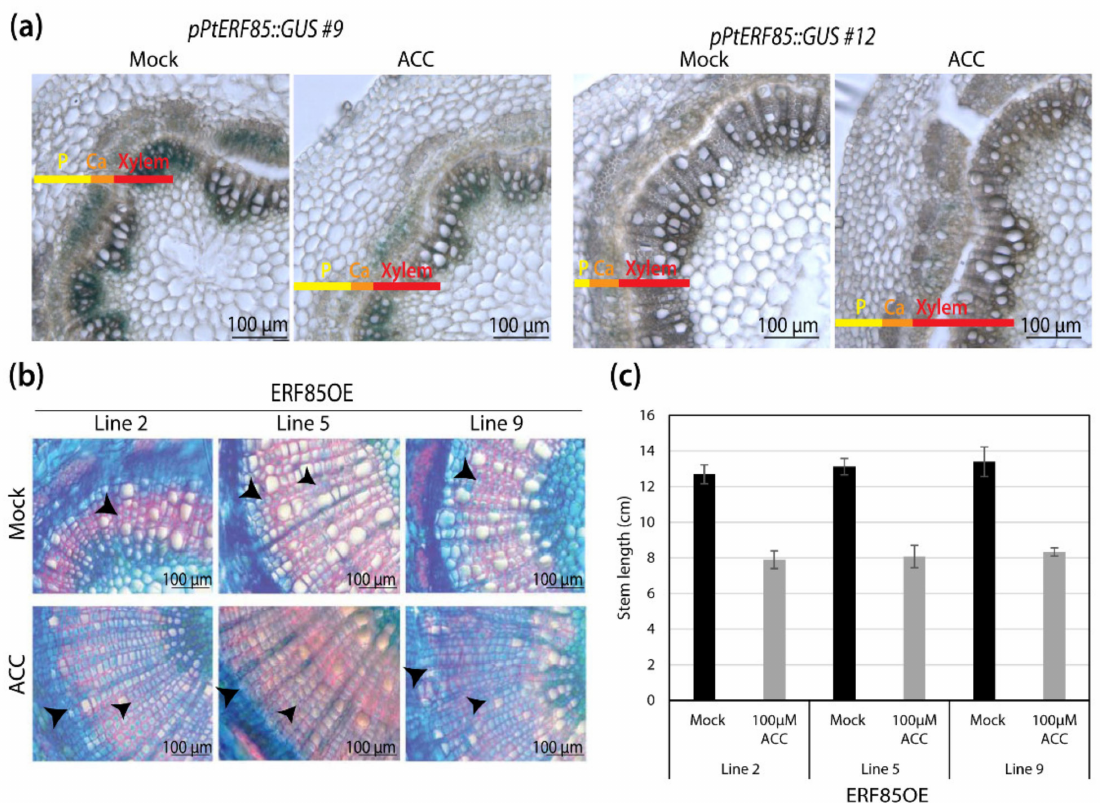
Figure 2. ERF85OE lines showed enhanced ethylene-mediated stem phenotypes. ( a ) GUS staining in two transgenic lines that carry a pPtERF85::GUS reporter. Transgenic reporter lines were treated for 10 h with either water (mock) or 100 µ M ACC. ( b ) Stem cross-sections from WT, transgenic ethylene-insensitive trees ( pLMX5::etr1-1 ; [13]), and ERF85OE lines. Trees were treated with 10 µ M ACC for 14 days. Cross-sections (50 µ M-thick) were stained with safranine and toluidine blue and magnified using a 20-fold objective. Arrows highlight the onset of a gelatinous (G)-layer in xylem fibers [14]. ( c ) Plant height of ERF85OE lines in response to water (mock) or 100 µ M ACC treatment for 14 days. Bars represent the average height (+/ − standard error) obtained from five biological